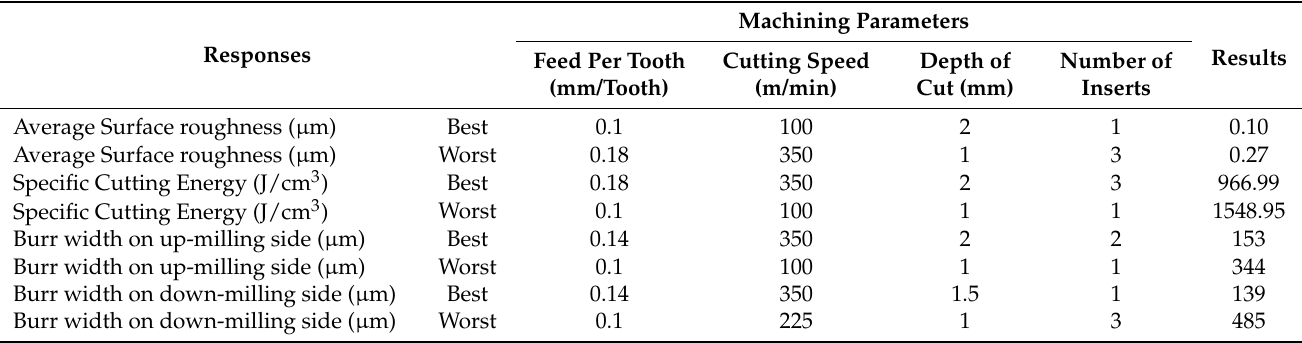
Table 9. Best and worst machining conditions for recorded